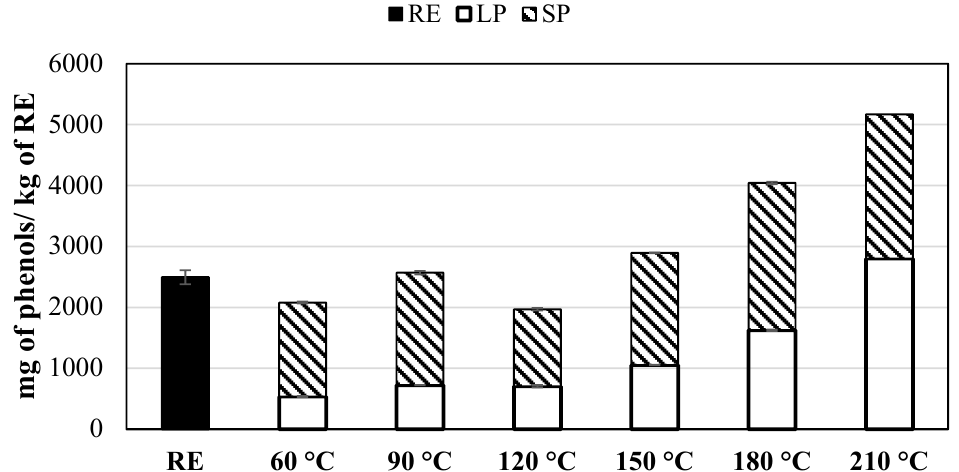
Figure 3. Phenols expressed as milligrams of gallic acid equivalents per kilogram of extrudate for untreated RE and different fractions obtained after the hydrothermal treatments.